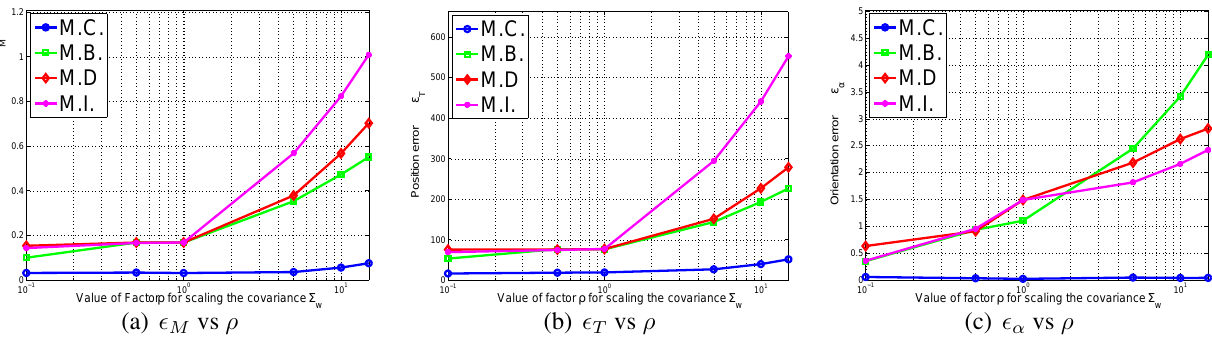
Figure 9. Experiment showing the different initialization errors in function of the amount of error in odometry